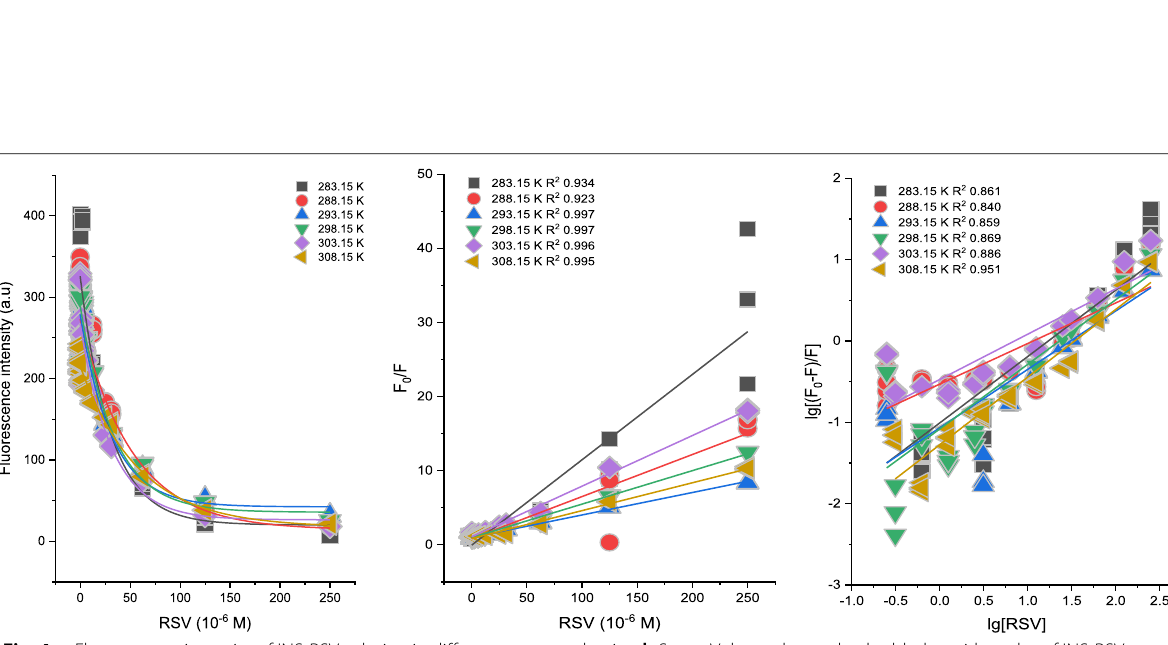
Fig. 4 a Fluorescence intensity of INS‑RSV solution in different resveratrol ratios, b Stern–Volmer plot, and c double‑logarithm plot of INS‑RSV